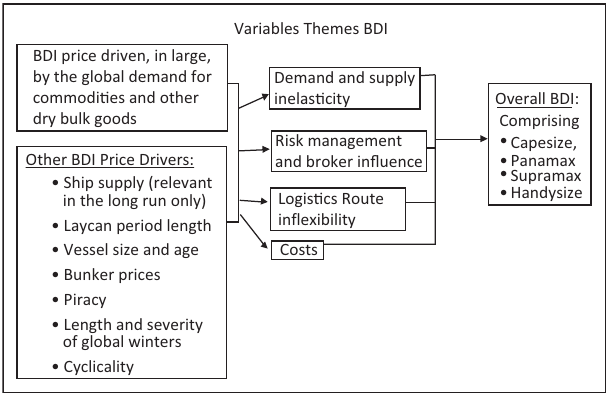
FIGURE 3: Factors influencing the Baltic Dry Index and its resultant impact on economic activity.